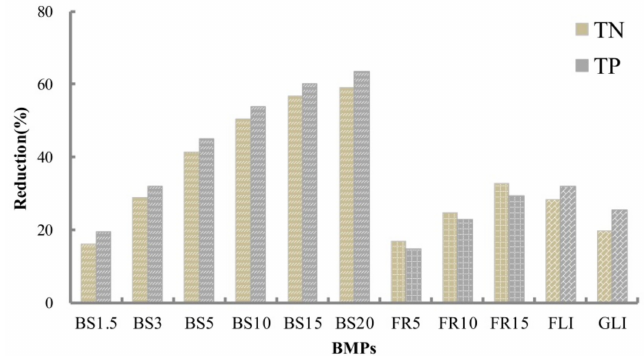
Figure 9. TN and TP loads reduction of each BMP implementation in the Soil and Water Assessment Tool (SWAT)